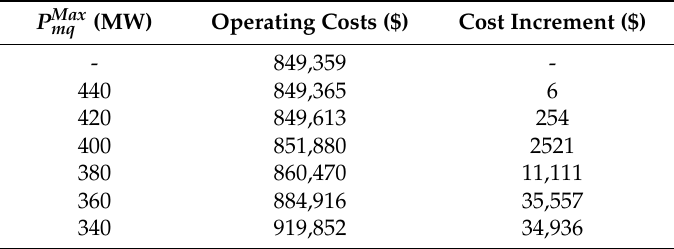
Table 3. Impact of congestion on the operational